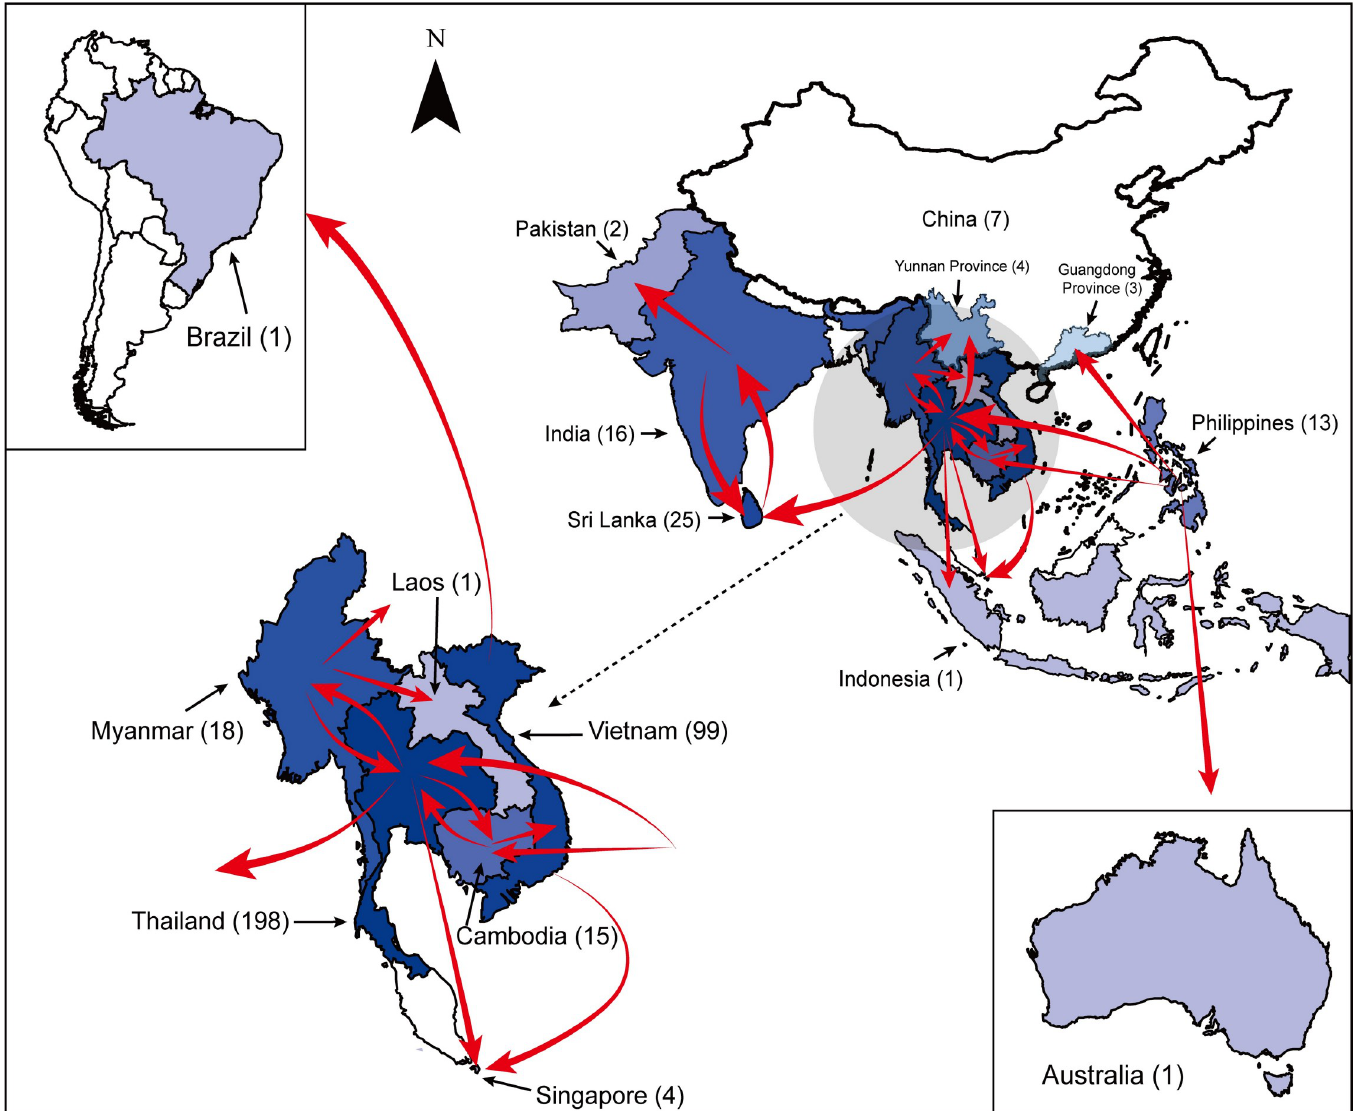
Fig 4. The global dissemination pathways of DENV 4-I. Driven by the phylogeographical analysis of all included strains, red arrows indicate the probable direction of trans-border expansion of DENV4-1. The number of unique strains ( < 100% similarity in the same year) in each location is shown in parenthesis after each location name.